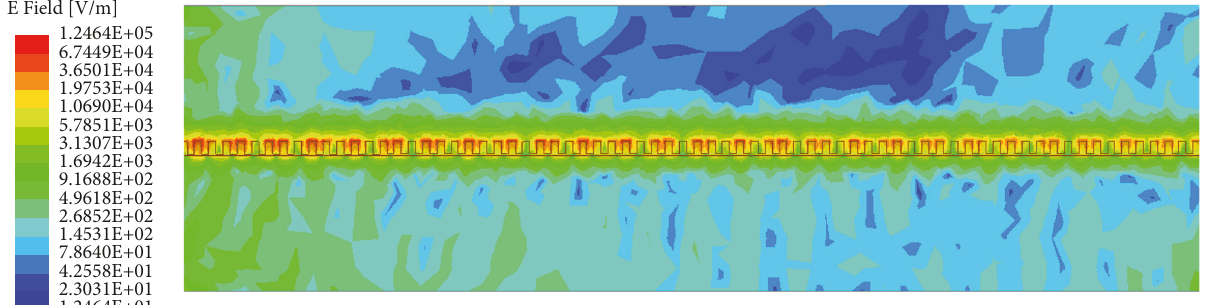
Figure 3: Electric field distribution of SSPP by HFSS.